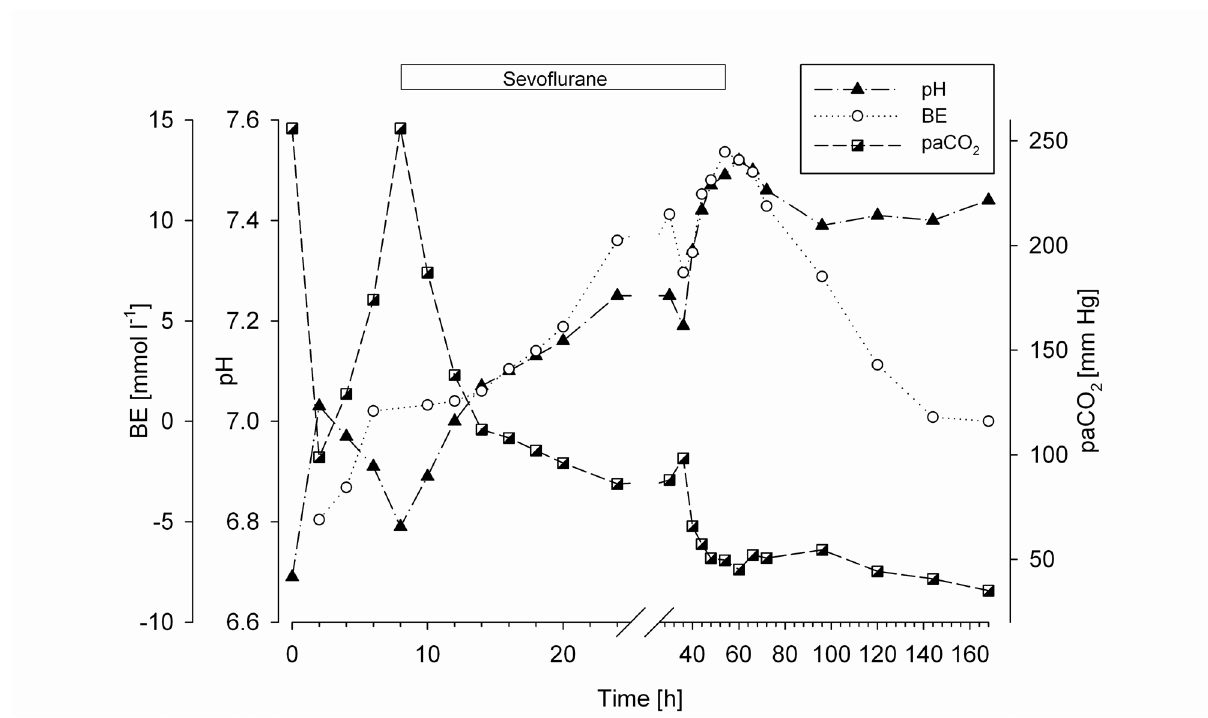
Figure 2. Base excess (BE) and pH are shown on the left side of the y-axis. Partial pressure of arterial CO side of the y-axis. Time course in hours (h) is shown on the